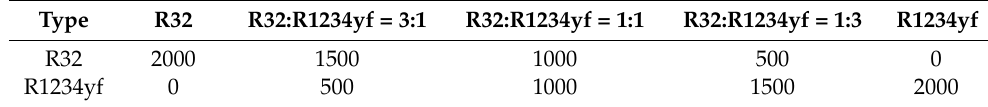
Table 1. Number of molecules in mixed refrigerant system.